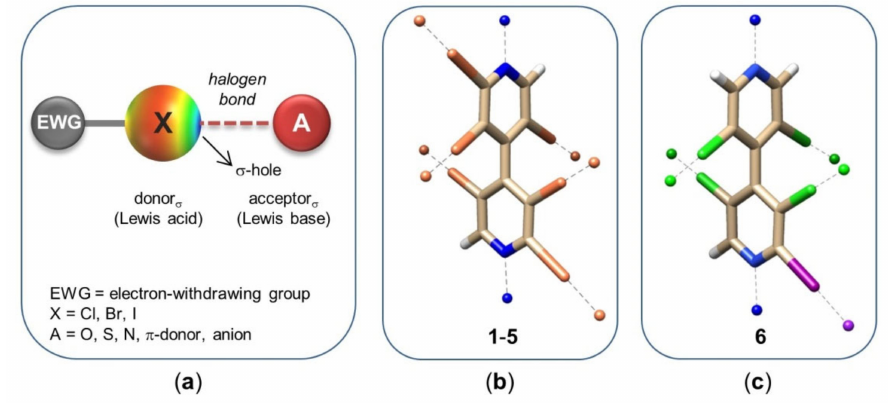
Figure 4. ( a ) Schematic description of XB. On X surface, electrostatic potential ( V S ) > 0 (lower electron density) and V S < 0 (higher electron density) are indicated in blue and red, respectively. Intermediate values are in orange, yellow, and green; ( b ) and ( c ) positions of nitrogen V S,min regions (blue) and V S,max in the structure of halogenated 4,4 (cid:48) -bipyridines 1 – 5 and 6 (hydrogen, white). V S,max colors: halogen, coral; chlorine, green; iodine,